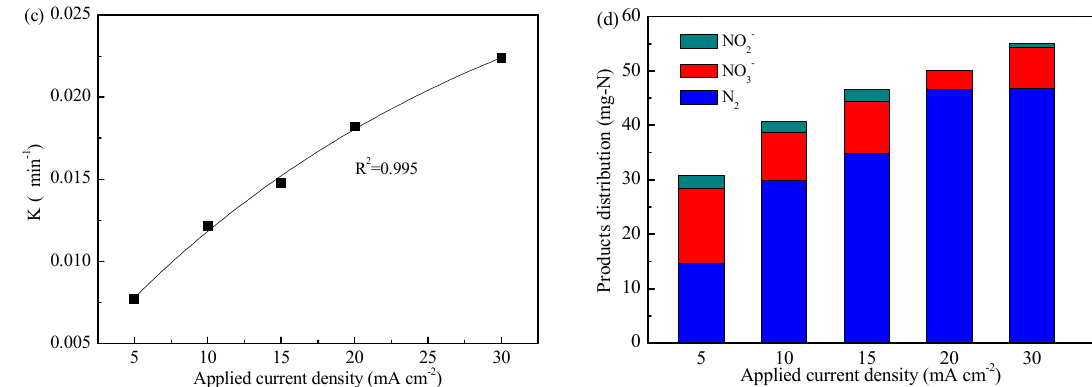
Figure 2. Function of applied current density on ammonia removal ( a ), kinetics analysis ( b ), kinetics relationship ( c ), and products distribution ( d ). Initial pH value of 8.3 and a flow of 100 mL min − 1 .